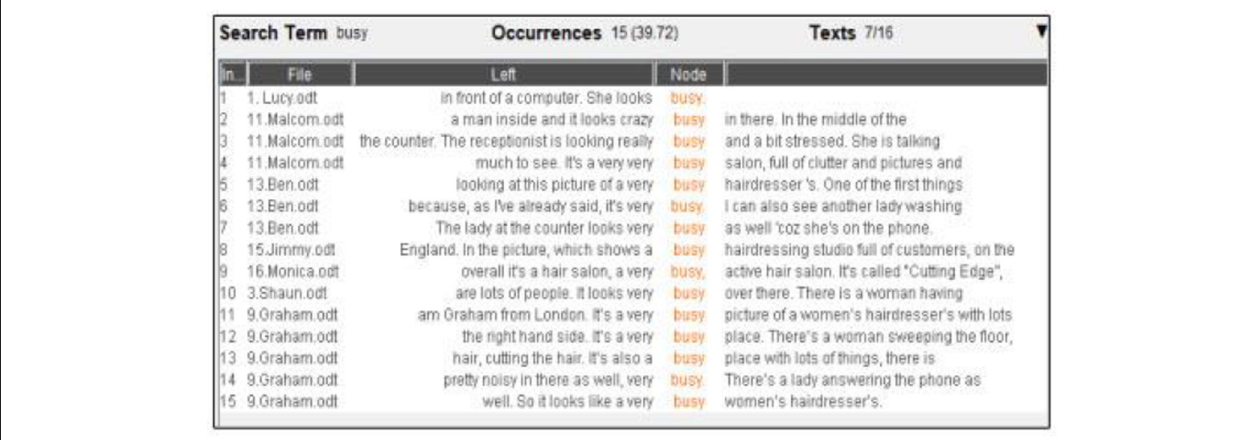
FIGURE 8 | Busy—LancsBox.